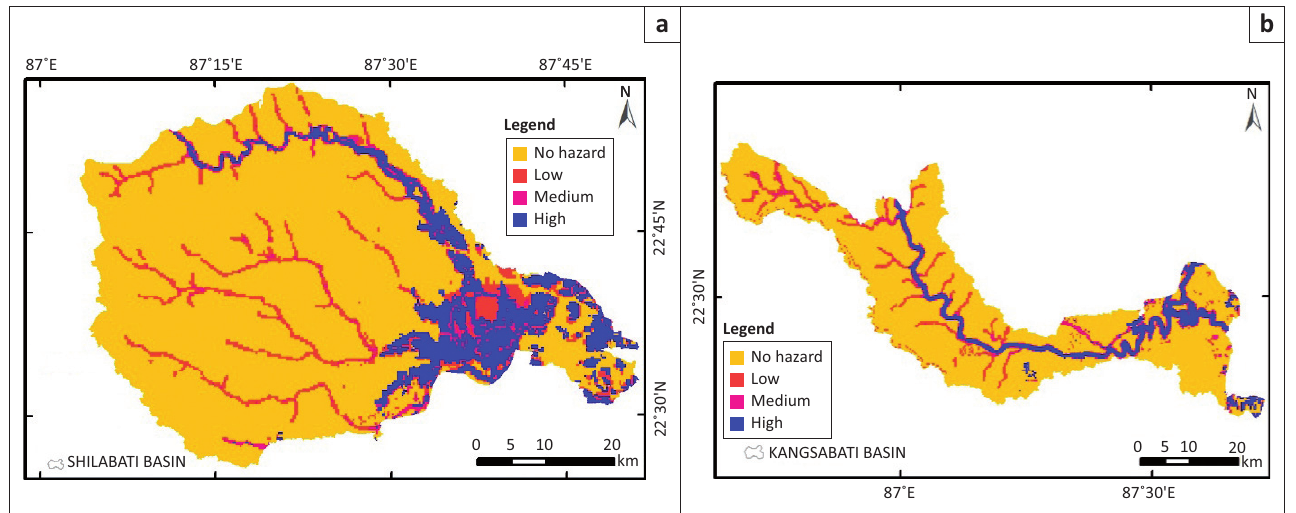
FIGURE 9: (a) Flood hazard map of Silabati Catchment and (b) Kangsabati